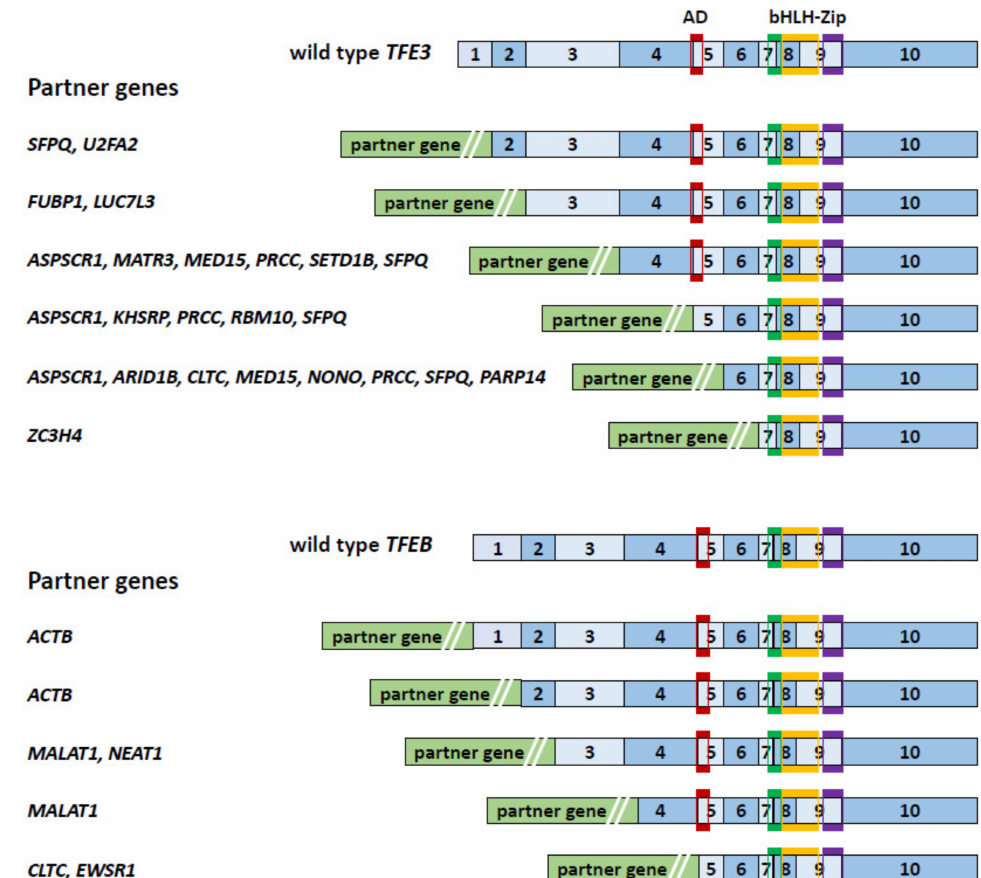
Figure 2. Structures of TFE3 fusion and TFEB fusion genes. The structures of TFE3 fusions and TFEB fusions found in TFE3 -rearranged RCC and TFEB -altered RCC are shown. Wild-type TFE3 and TFEB have 10 exons. The fusion partner genes are listed. All of the fusion genes retain coding exons for